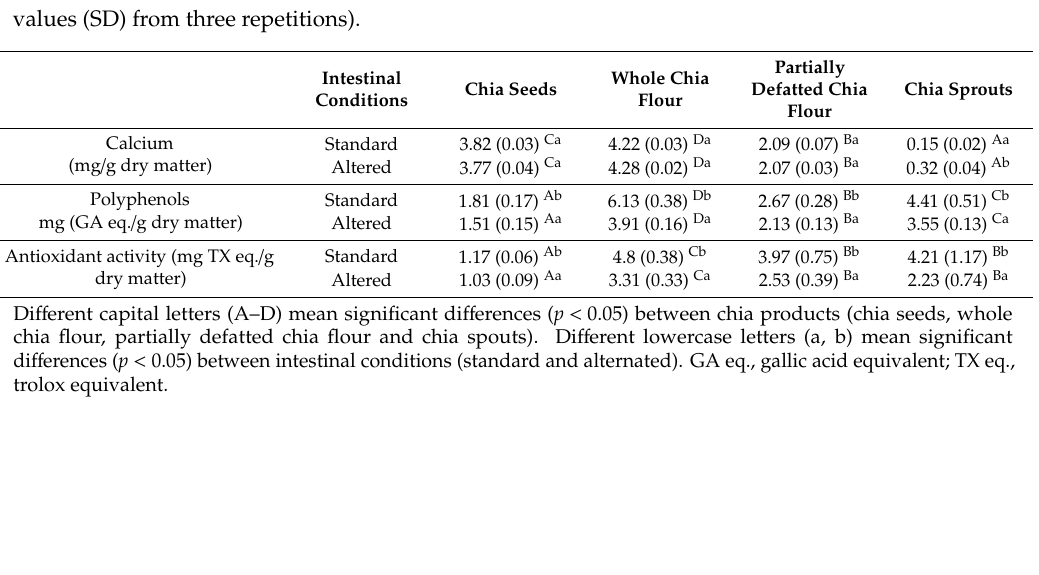
Table 3. Concentration of calcium, polyphenols and antioxidant activity in the bioaccessible fraction after in vitro digestion under standard and altered intestinal conditions (data are expressed as mean values (SD) from three repetitions).